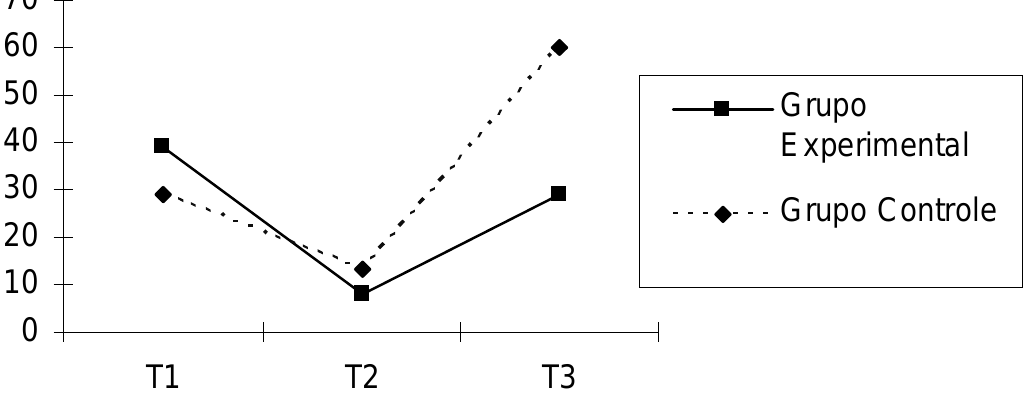
Figura 1. Comparação dos grupos de intervenção e controle com relação a unidades de consumo de álcool por dia em T1, T2 e